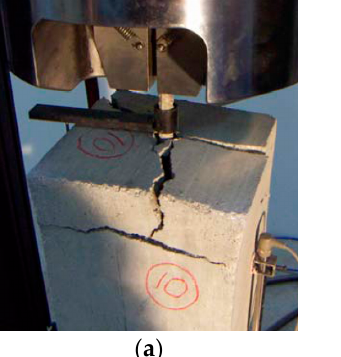
Figure 8. Concrete tensile failure: ( a ) specimen S10; ( b ) specimen S52.